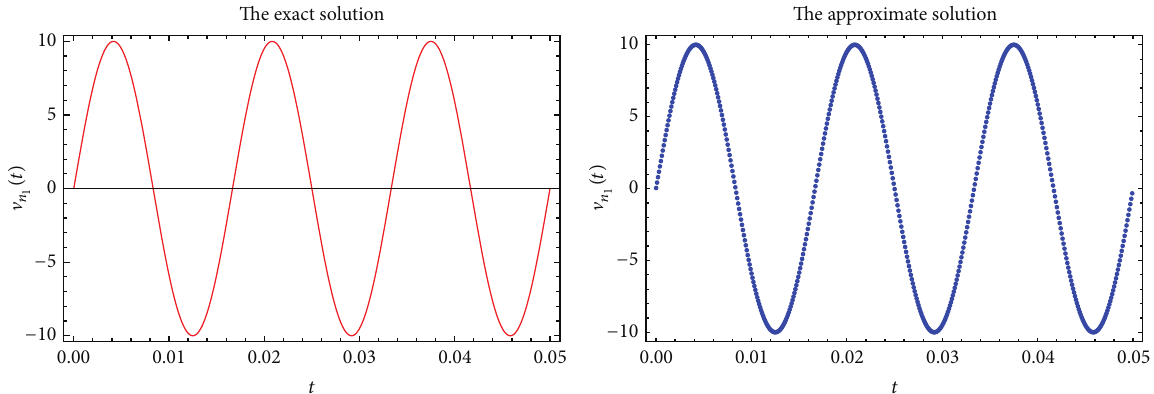
(𝑡)) of the diode 1